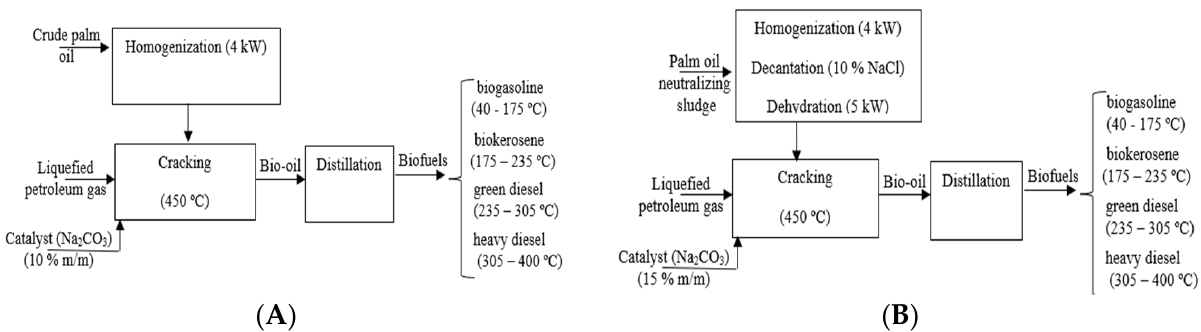
Figure 2. ( A )—process scheme of palm oil ( Elaeis guineensis , Jacq) conversion into in biofuels and ( B )—process scheme for conversion of palm oil neutralization sludge in biofuel.